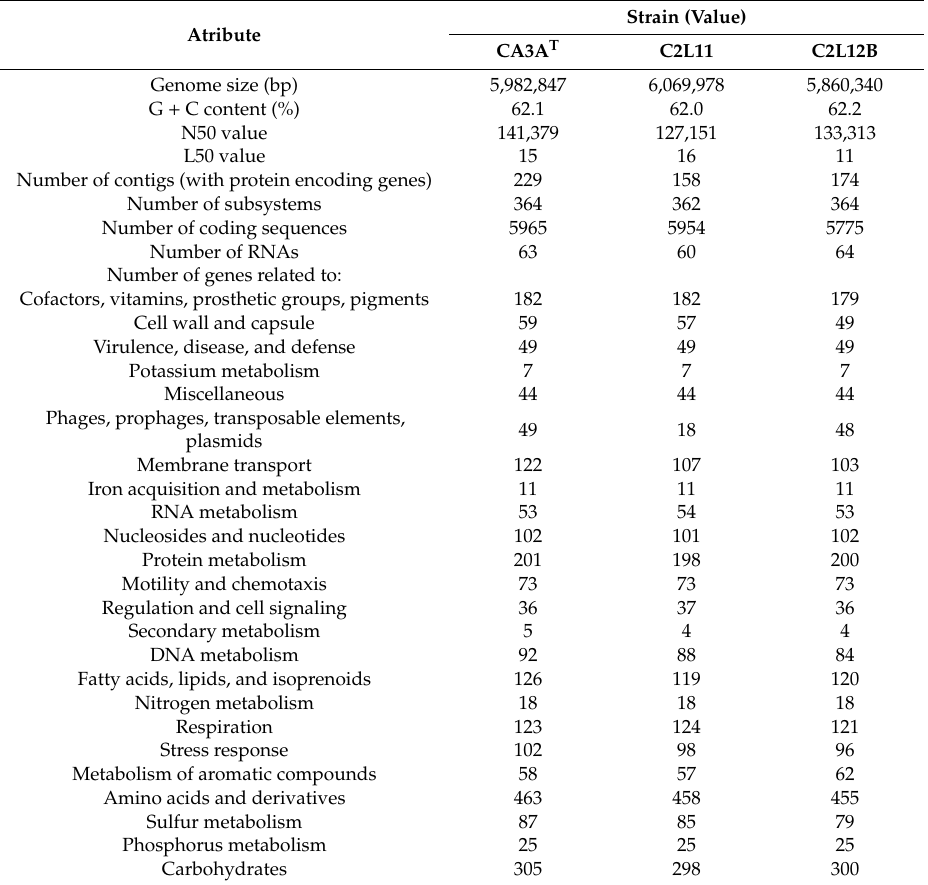
Table 3. Strain CA3A T , C2L11, and C2L12B genomes description based on RAST